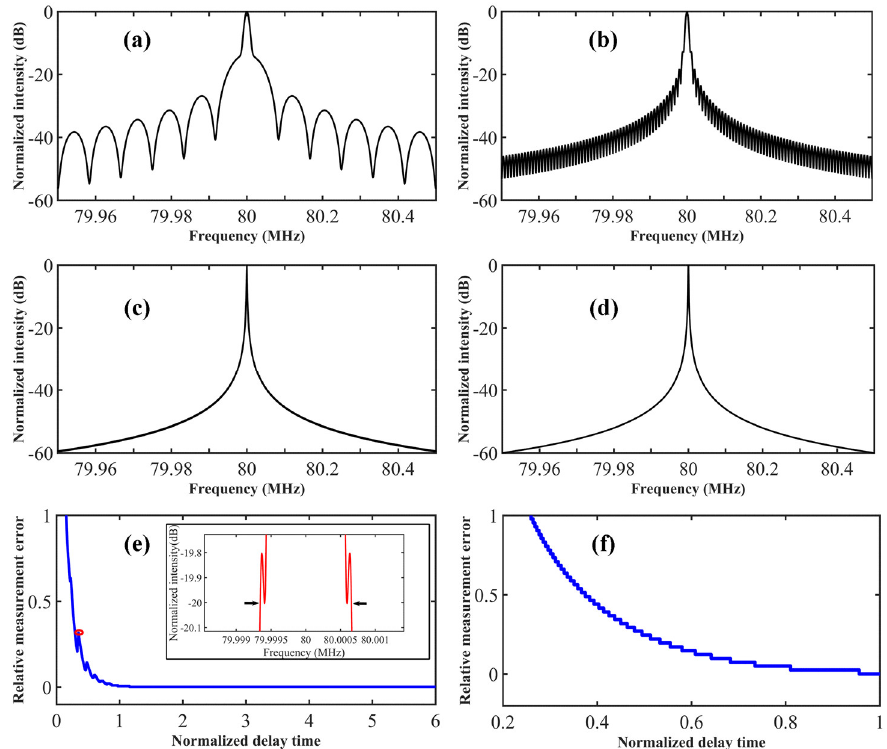
Figure 3. The simulated self-heterodyne spectrum when the ratio of delay time to coherent time is ( a ) 0.006, ( b ) 0.06, ( c ) 0.6, and ( d ) 6. The relative measurement error with different delay time when the laser linewidth is calculated from the ( e ) 20-dB bandwidth and ( f ) 3-dB bandwidth. Inset, the zoomed in self-heterodyne spectrum corresponding to the read mark. Parameters used in simulation: f = 50 Hz, n = 1.5, Ω = 80 MHz.